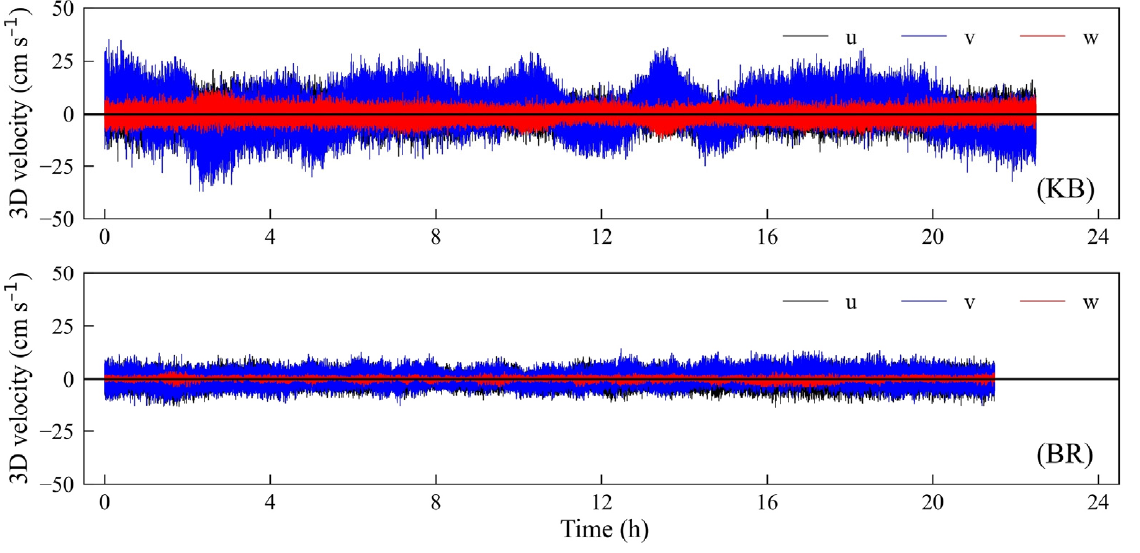
Figure 3. Raw 3D velocity for the approximately 24 h time series of AEC data in KB and BR. The black, blue, and red lines represent the u, v, and w components measured at 32 Hz, respectively. Table 1. Photosynthesis parameters and net ecosystem metabolism in KB and BR. P max , R d , GPP, R, and NEM are in mmol m − 2 d − 1 , I k and I c are in µ mol photon m − 2 s − 1 , and α is in mmol m −